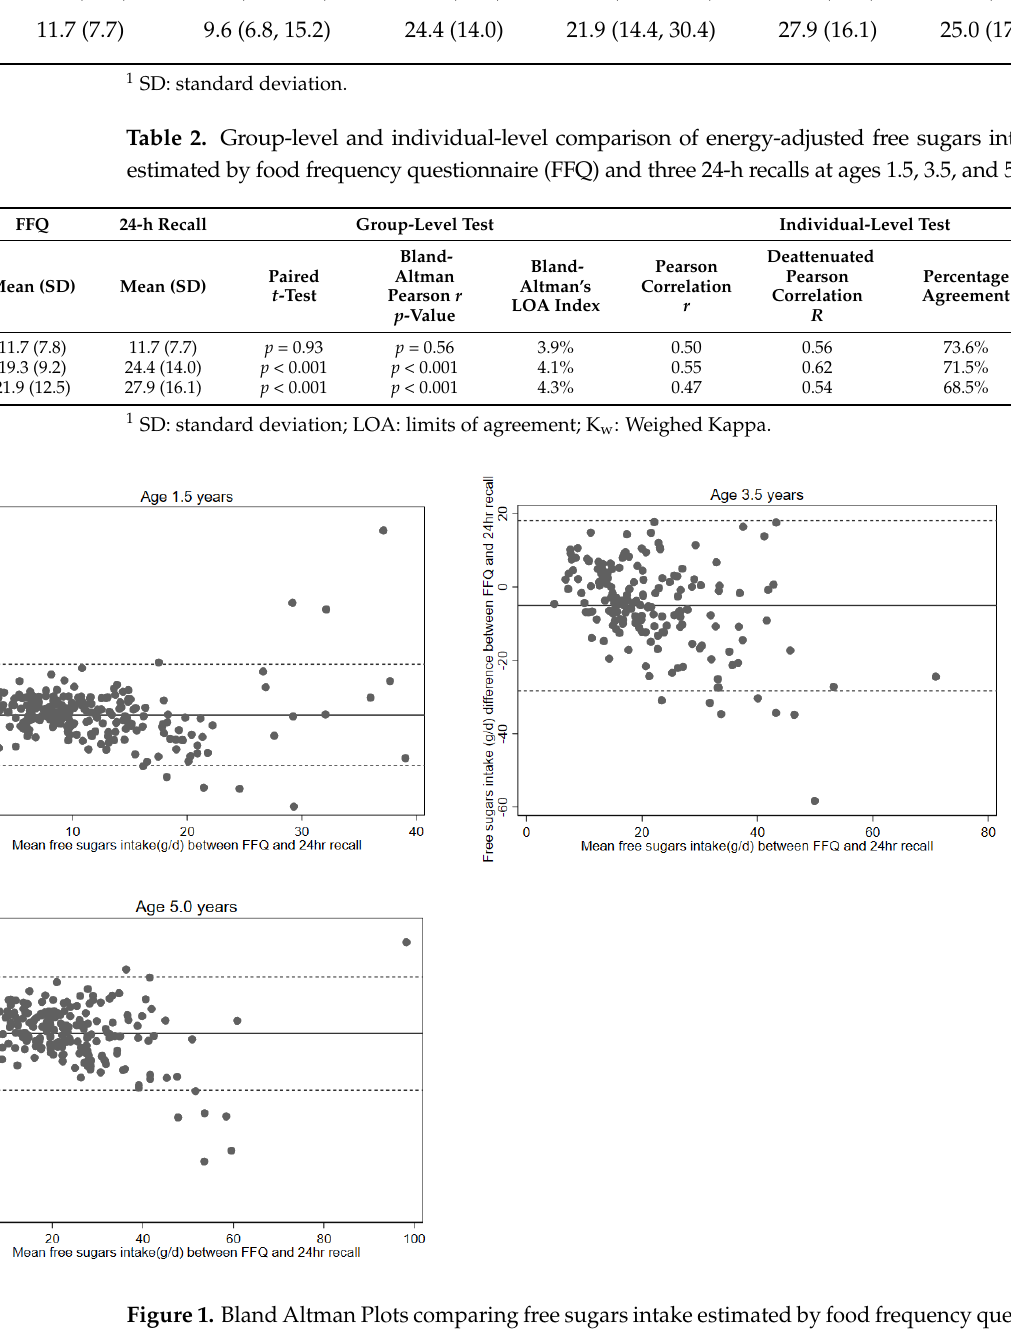
Figure 1. Bland Altman Plots comparing free sugars intake estimated by food frequency questionnaire (FFQ) and three 24-h recalls at ages 1.5, 3.5, and 5.0 years. Dotted lines as +/-2 SD. With respect to individual-level tests (Table 2), the deattenuated correlation ( R ) be- tween FFQ and 24-h estimates exhibited good agreement across three time points, with correlation coefficients ranging from 0.54 to 0.62. Similarly, the percentage agreement of free sugars intake (within first quintile) showed a good outcome, with the highest agreement at age 1.5 years (73.6%), followed by age 3.5 years (71.5%) and 5.0 years (68.5%). Weighted kappa revealed acceptable agreement at all three time points (K w 0.26 to 0.39). 4. Discussion Describing young children’s free sugars intake is important given the detrimental influence of free sugars on child dental caries and health. Our study evaluated the valid- ity of InFANT FFQ, an existing quantitative FFQ, for estimating free sugars intake rela- tive to three 24-h recalls over three time points in early childhood. We used a combina- tion of statistical tests to obtain comprehensive insights into different aspects of group and individual level validity. The InFANT FFQ showed good validity for both group and individual level tests at age 1.5 years. For ages 2.5 and 5.0 years, the FFQ showed good validity for individual-level tests, but not for group-level tests. The good individual level validity at ranking participants across three time points supports the utility of the InFANT FFQ in assessing diet and disease relationships in ep- idemiological studies [24]. At the group-level comparing absolute intakes, FFQ and 24-h recalls estimated similar free sugars intake at age 1.5 years. However, the InFANT FFQ underestimated free sugars intake against 24-h recalls at ages 2.5 and 5.0 years. Moreo-